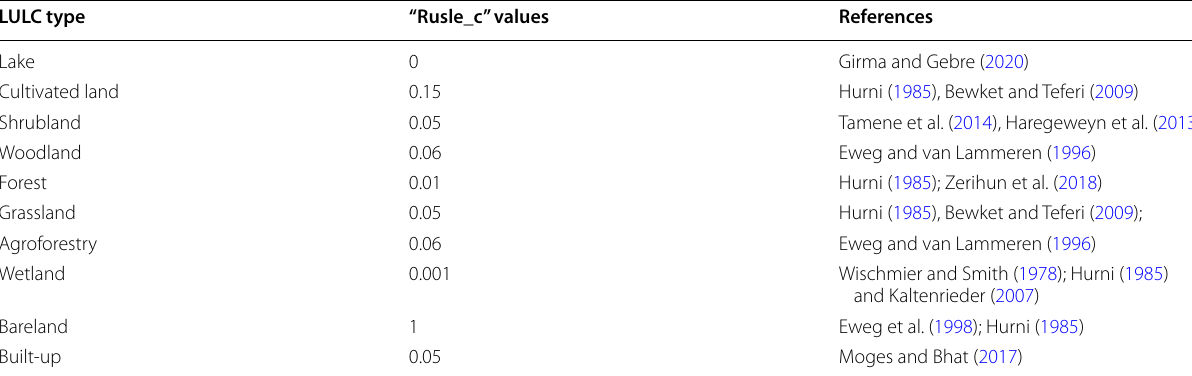
Table 2 Adopted values of “rusle_c” factor for different LULC classes